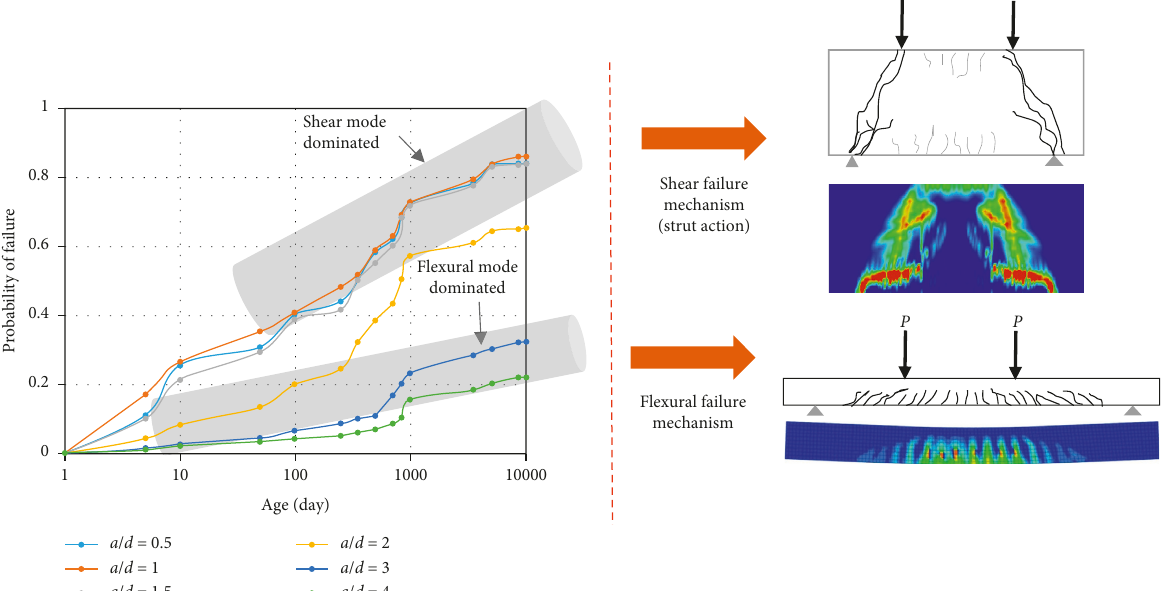
Figure 11: Collapse probabilities of RC beams in the strength limit state at a load level of P